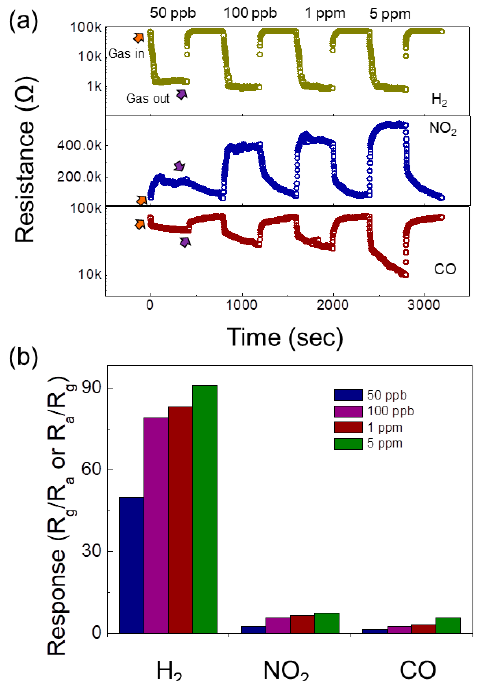
Figure 7. ( a ) Dynamic response curves of the 0.1 SnO 2 -loaded ZnO NFs gas sensor to H 2 , NO 2 and CO